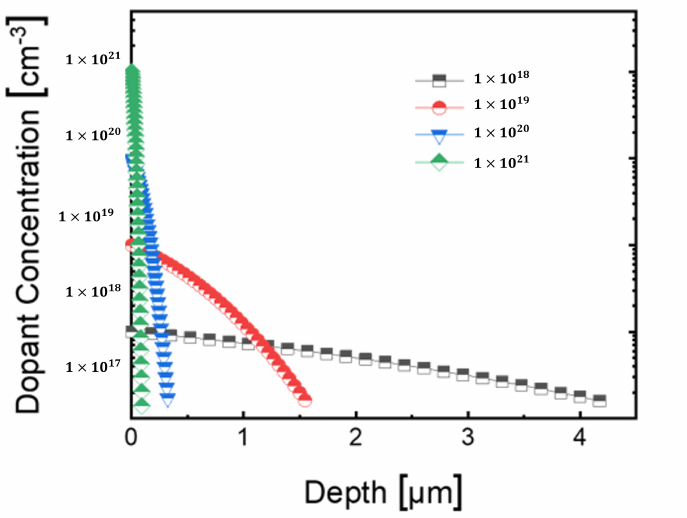
Figure 7. Variation in the emitter dopant concentration by fixing R sheet